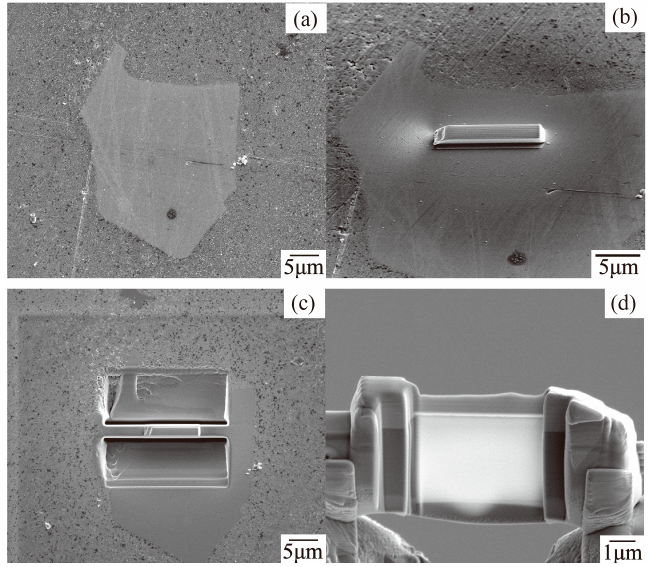
Figure 13. SEM images of a TEM film obtained using FIB: ( a ) Found a region, ( b ) Rough cutted, ( c ) Cutted off the sample and extracted it, ( d ) Transmitted it to the TEM copper target and using a FIB for the preparation of an ultra-thin sample.